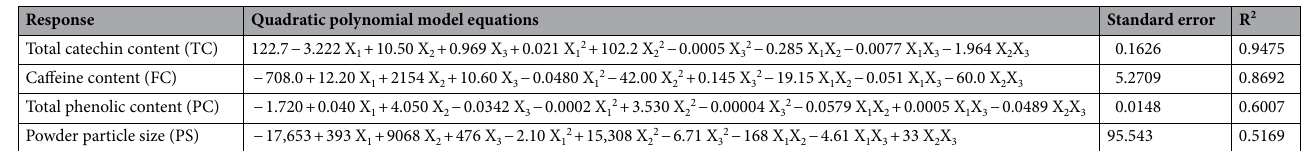
Table 4. Model equations of the